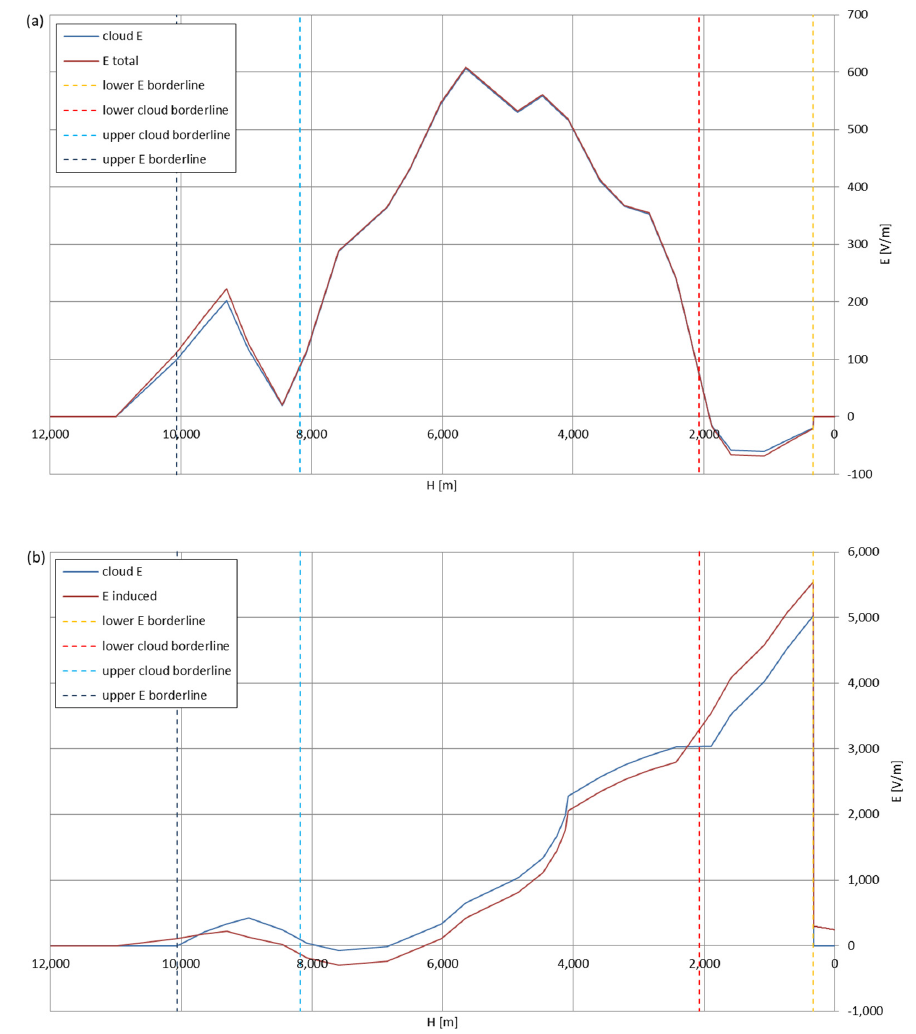
Figure 18. Maximum electric field strengths around the wire antenna re-entering through Nimbostratus cloud of mixed charge structure, Kyiv data: ( a ) ‘static’ case and ( b ) ‘dynamic’ case.